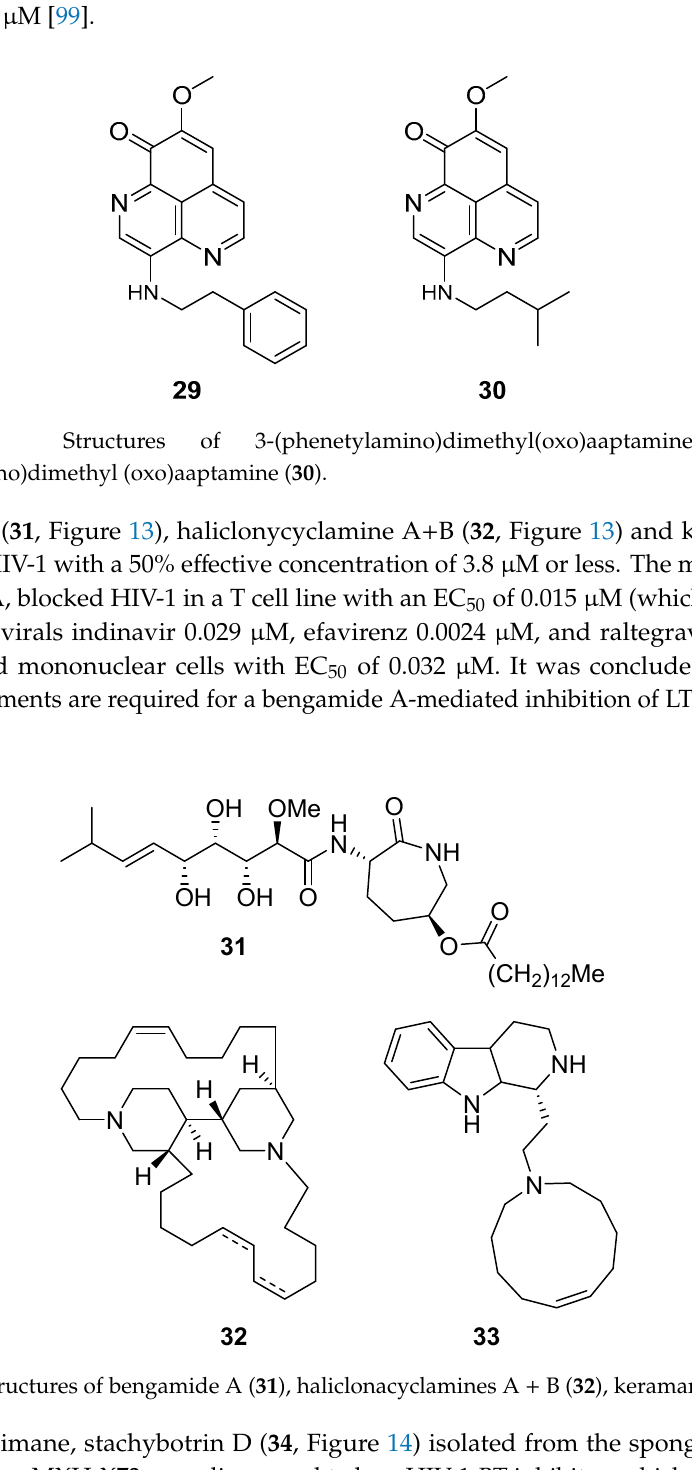
Figure and 3- Figure 12) and 3-